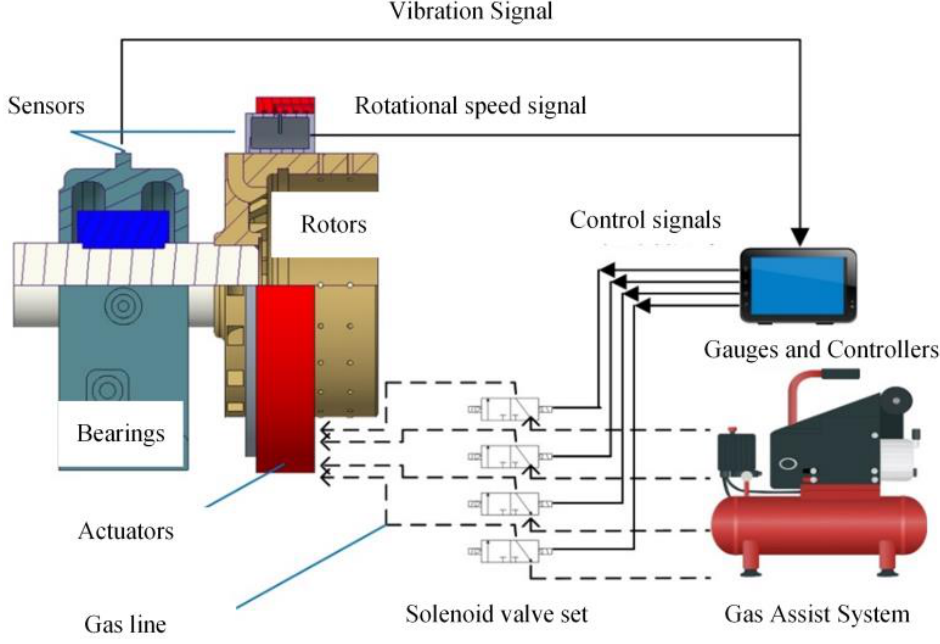
Figure 1. Composition of the PLOABS system.